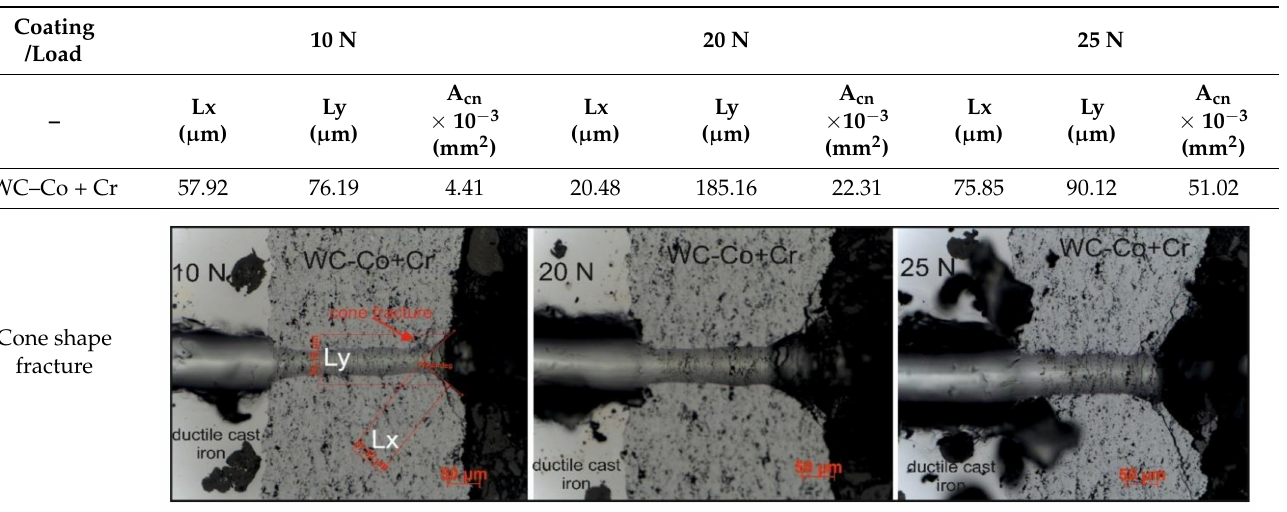
Table 5. Averaged scratch bond test results of WC–Co+Cr coating.